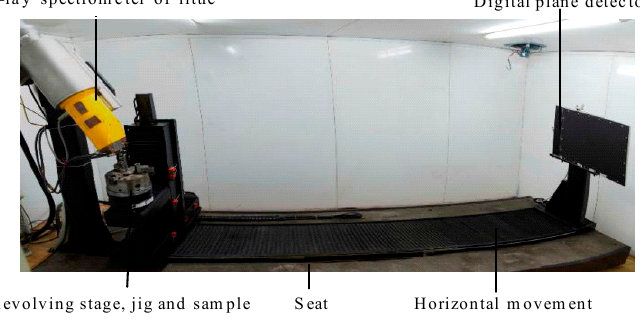
Figure 4. X-ray microtomography experimental system.